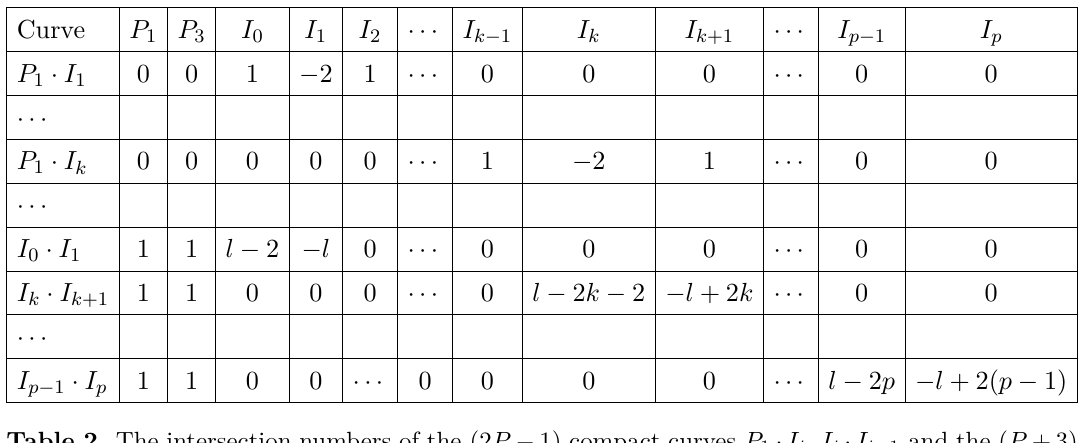
Table 2 . The intersection numbers of the (2 P − 1) compact curves P 1 · I i , I i · I i − 1 and the ( P + 3) points P 1 = ( − 1 , 1) , P 3 = ( l, 0) and I i = (0 , i ) , where i ∈ { 0 , 1 , · · · , p } , and k ∈ { 1 , 2 , · · · , ( p − 1) }